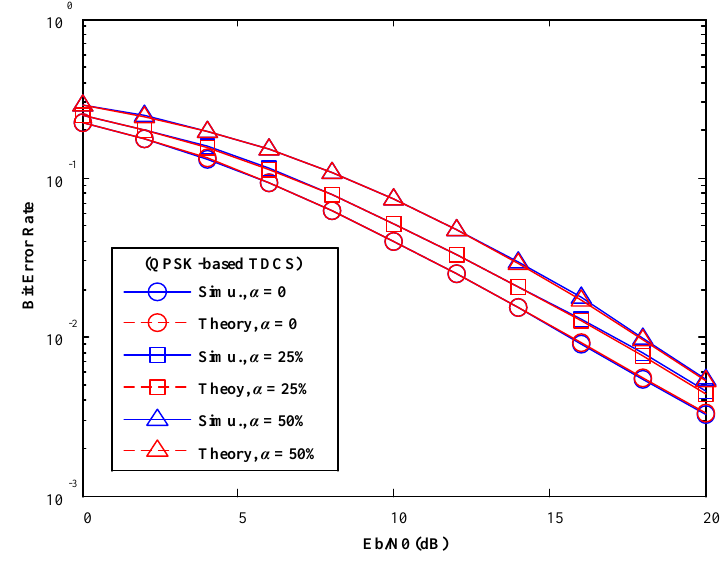
Figure 10. BER performance of TDCS-QPSK in multi-path channels (various mismatch factor